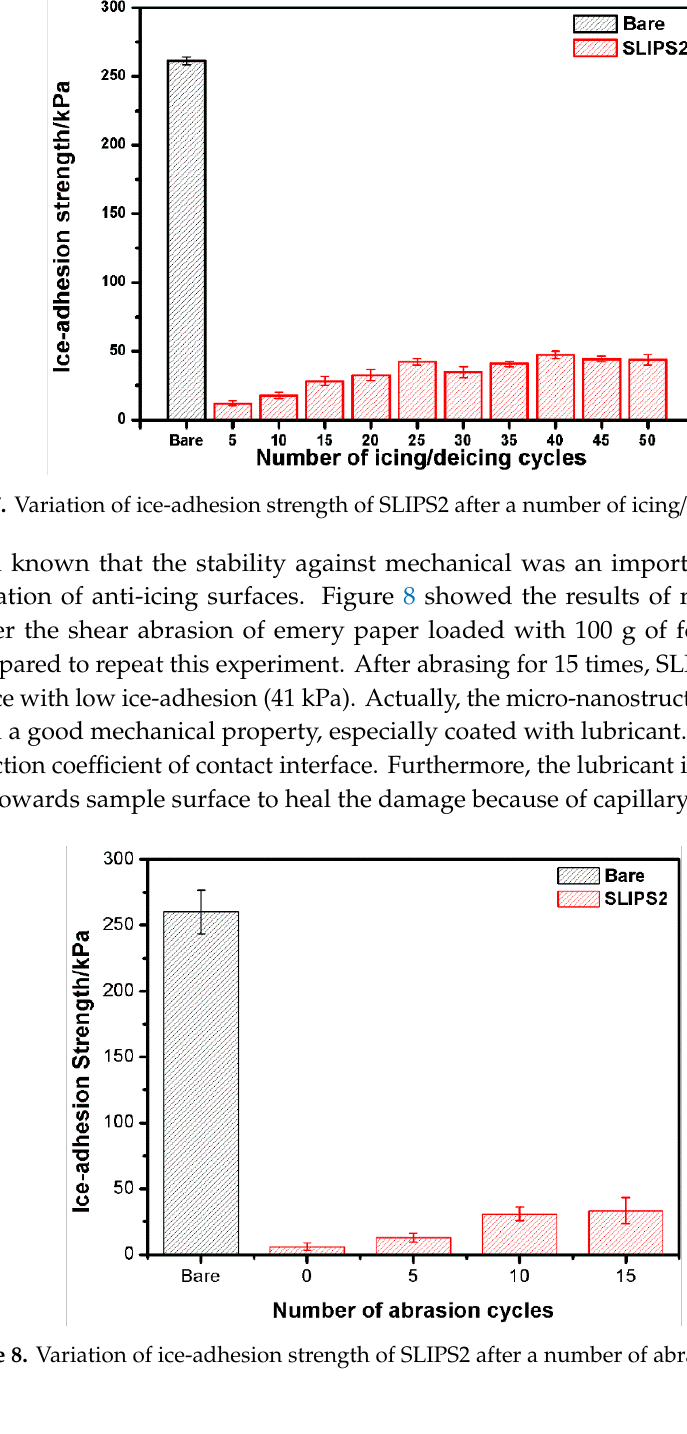
Figure 6. The number of freezing drops on bare samples, SLIPS1, SLIPS2 and SLIPS3 in each time period at − 5 °C ( a ) and − 10 °C ( b ).